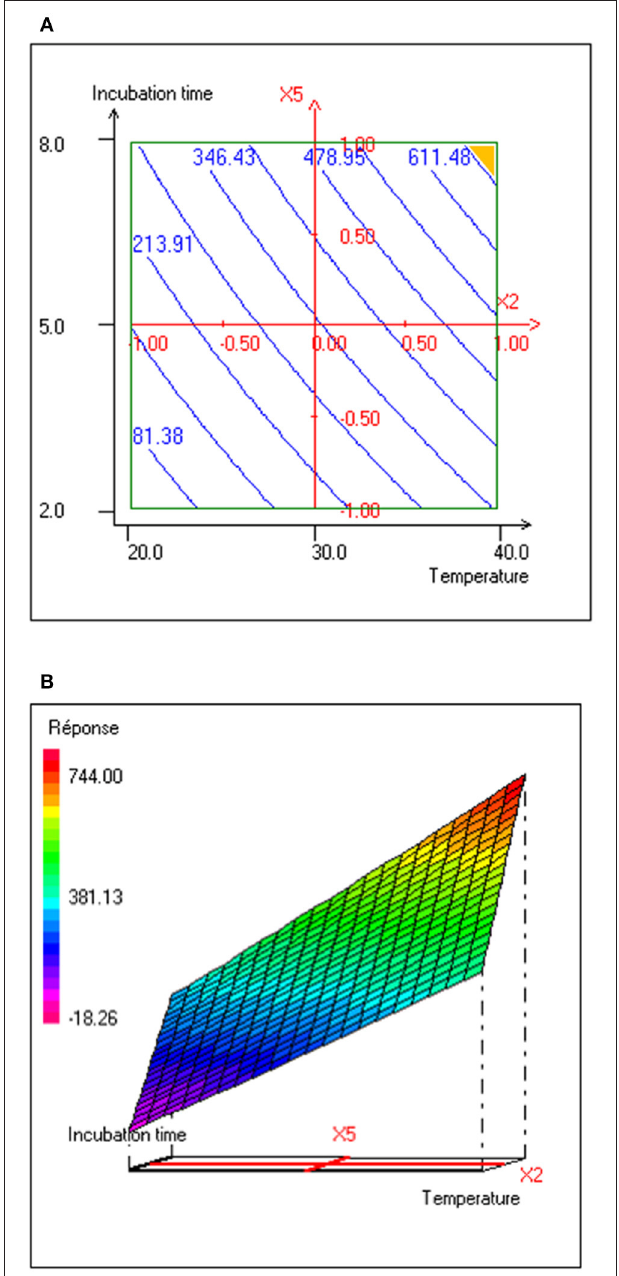
FIGURE 5 | (A) Contour plot and (B) response surface plot of interaction effect between temperature ( ◦ C) and incubation time (days) on BS production yield (mg/L) with pH, OMWW concentration and inoculum size kept at 6.0, 15% and 0.5%, respectively.